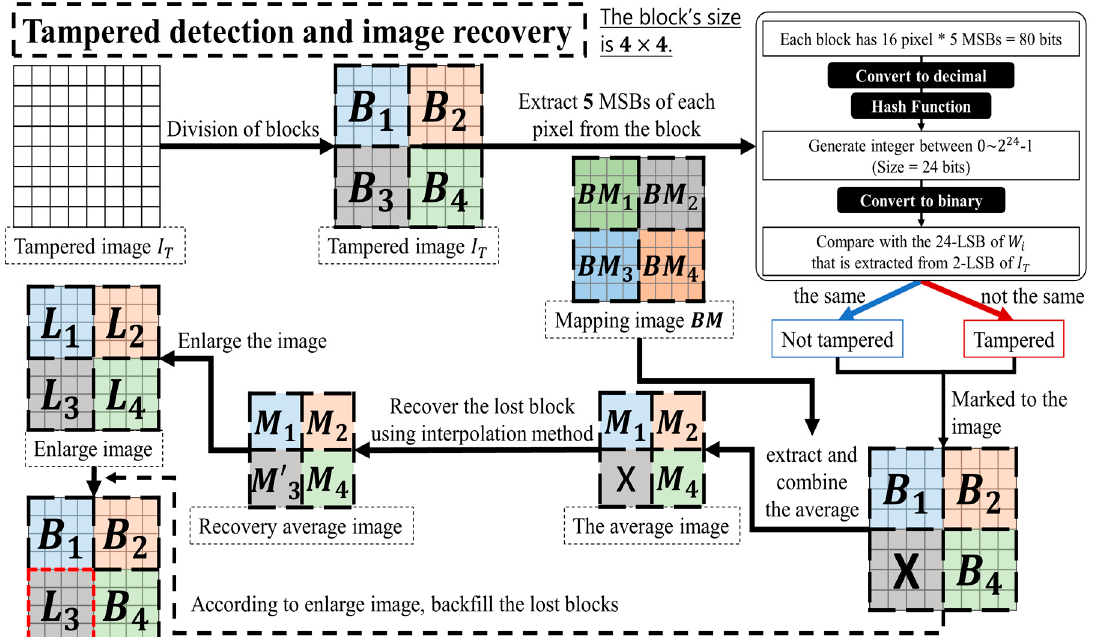
Figure 2. Flowchart of tamper detection and image recovery process based on “block-wise detection” (The size of a block is 4 × 4